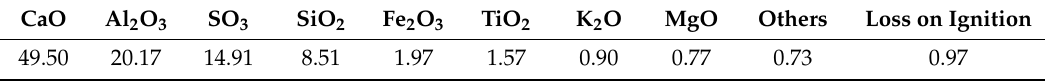
Table 1. The chemical components of the sulphoaluminate cement (SAC) (% by